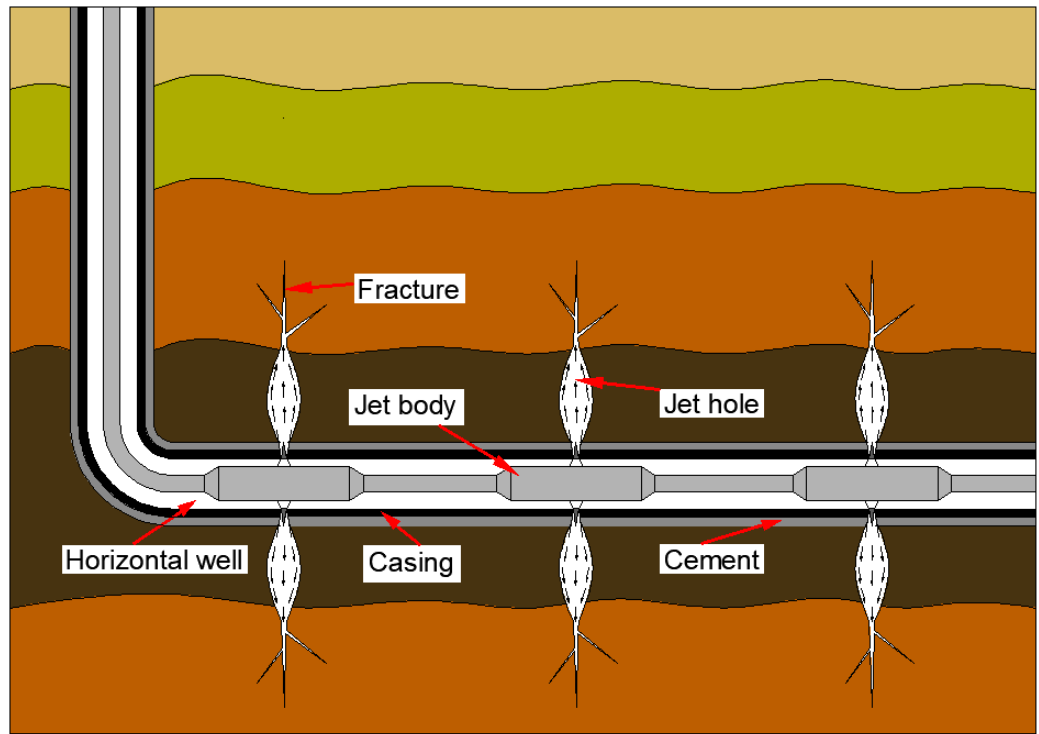
Figure 1. A schematic of hydra-jet fracturing.